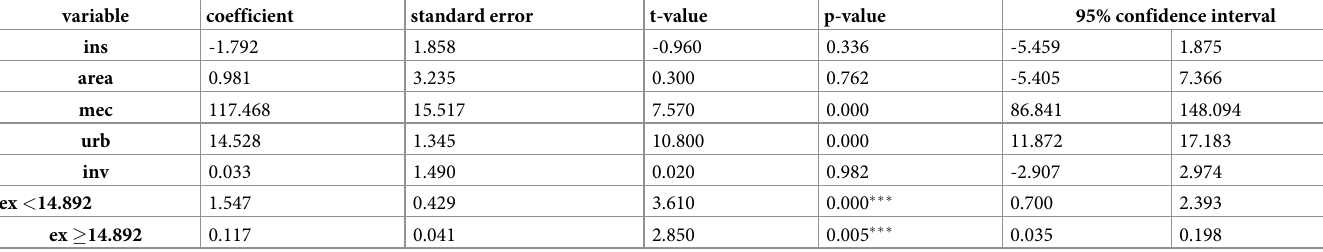
Table 10. Parameter estimation results of agricultural insurance per capita indemnity and farmers’ income single threshold model. variable